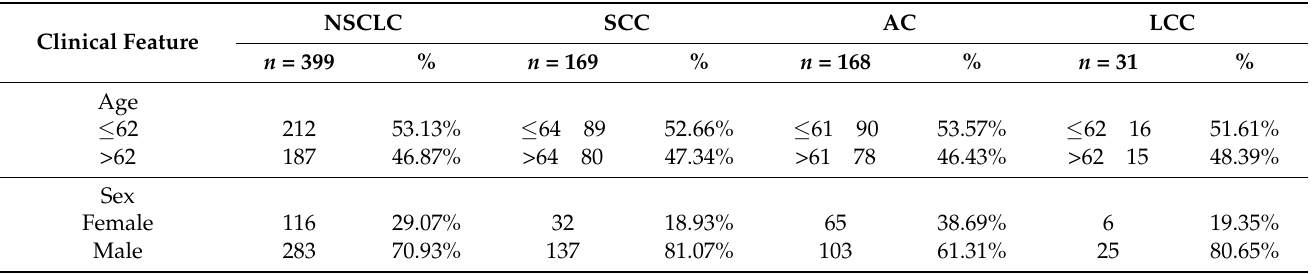
Table 1. Clinicopathological characteristics of patients with non-small cell lung cancer (NSCLC). Clinical